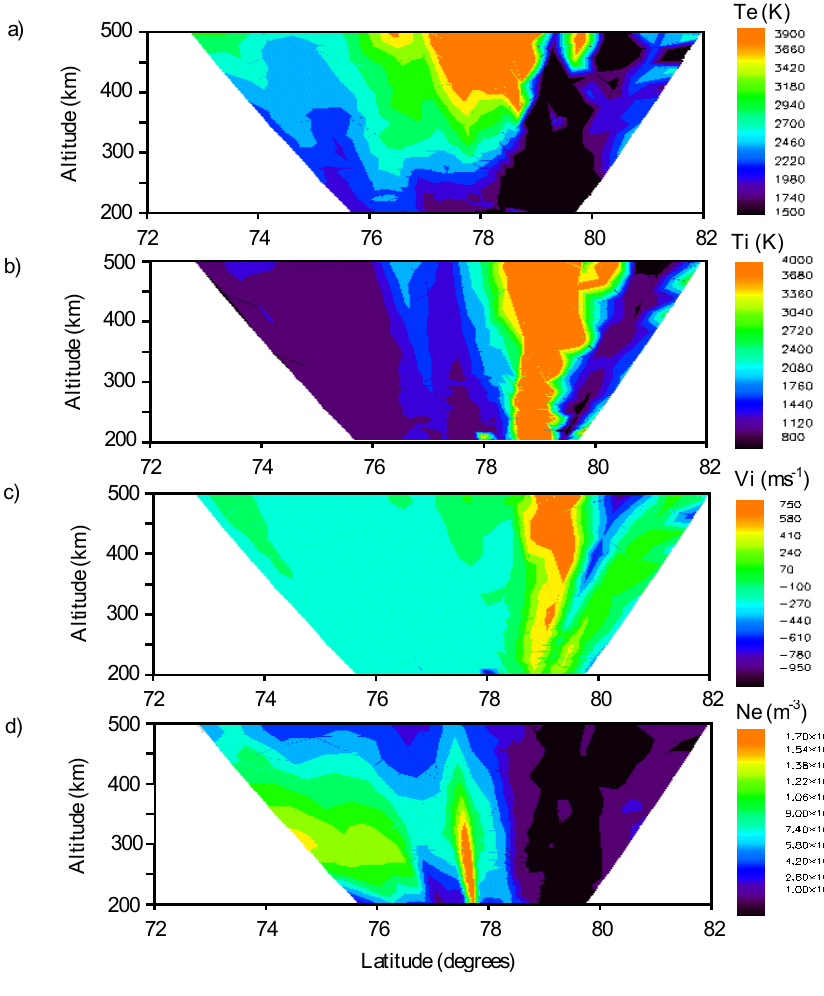
Fig. 2. (a) Electron temperatures, (b) ion temperatures, (c) line-of-sight ion drift velocities and (d) electron densi- ties measured by the ESR radar